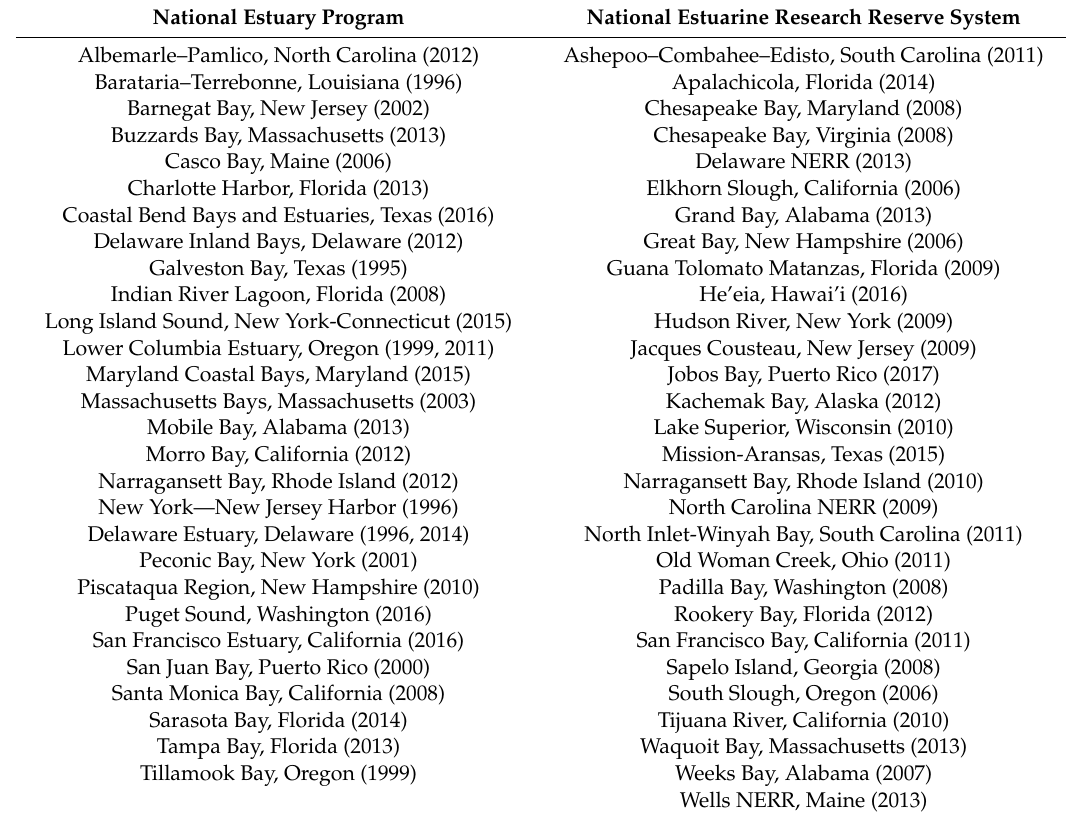
Table 2. List of National Estuary Program (NEP) and the National Estuarine Research Reserve System (NERRS) management plans and approval year included in document review. For plans intended as an addendum to a prior version, both years were